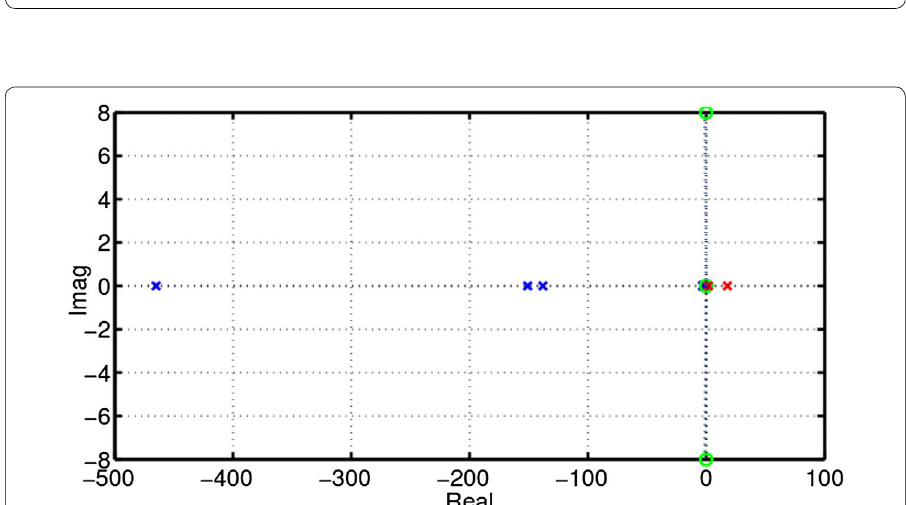
Fig. 9 Pole zero location of eigenvalues for the composite